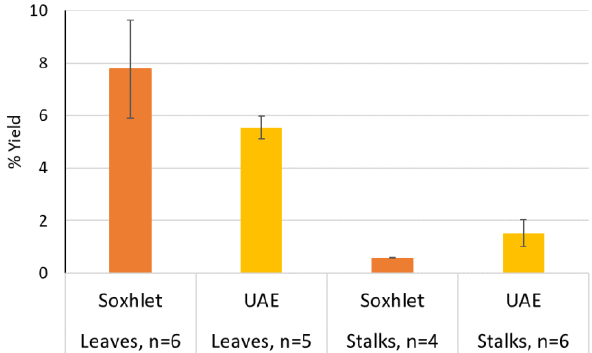
Figure 1. Percentage yield (mean ± SD) of DCM-extracts of leaves and stalks of sweet wormwood